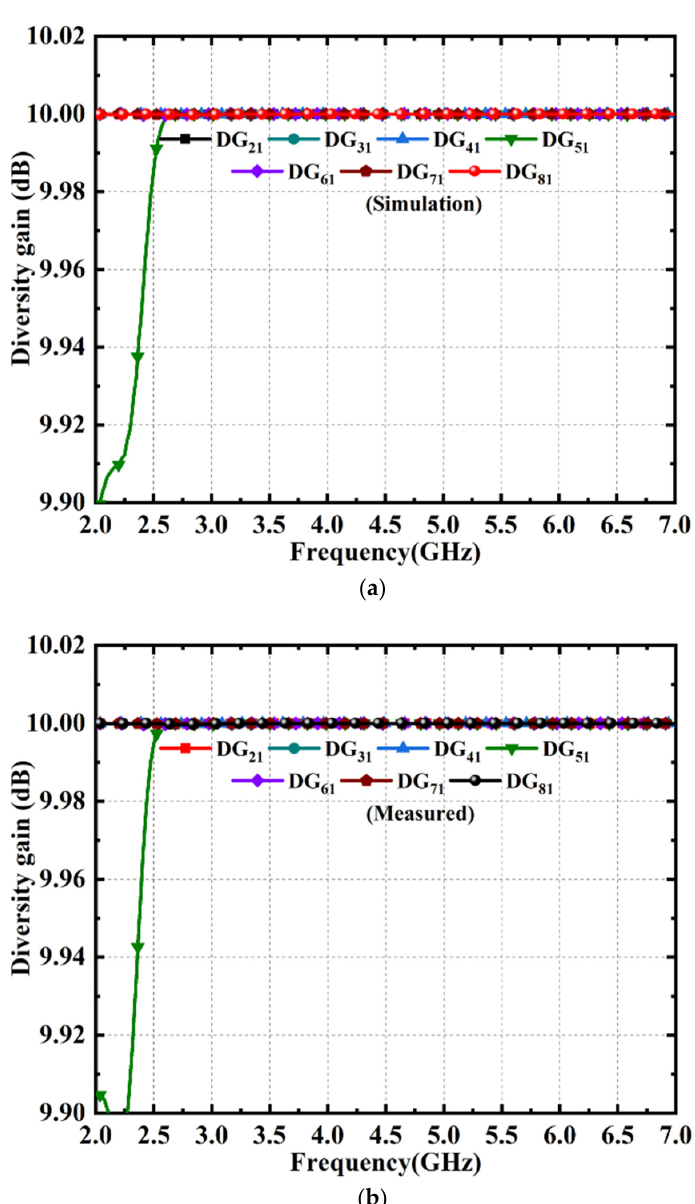
Figure 16. DG response: ( a ) simulation and ( b ) measured. Individual antenna S-parameter values are insufficient to analyze MIMO system performance when two or more antennas are placed next to each other. When both antenna elements are activated simultaneously, the radiation impacts the other antenna. Individual self-impedance and mutual impedance will vary. The S-parameters of individual MIMO antennas will not provide a perfect analysis. Total active reflection coefficient (TARC) is used to assess MIMO system behavior. TARC considers self and mutual impedance changes [36,37]. The following equation calculates the TARC for a two-port MIMO system (7). The proposed structure has TARC values below − 10 dB across the spec- trum Figure 17a,b.